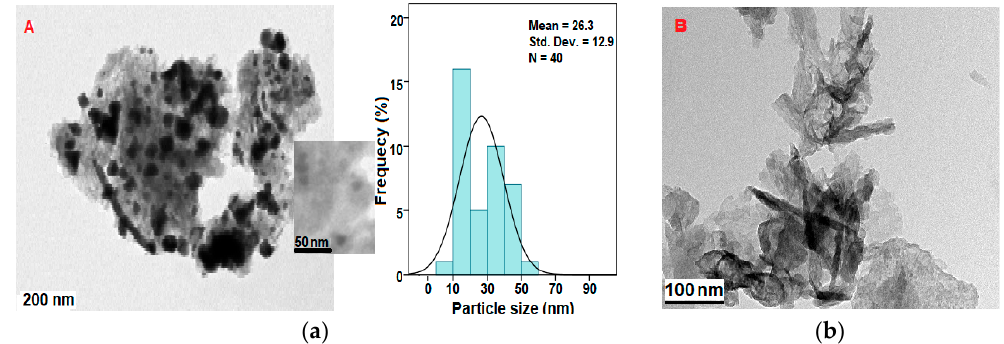
Figure 4. ( a ) Transmission electron microscopy (TEM) micrograph (A) and particle size distribution of gallic acid-intercalated in Zn/Al-LDH/Gd nanoparticles coated with AuNPs (GAGZAu) and micrograph (B); ( b ) of gallic acid intercalated in Zn/Al-LDH/Gd nanoparticles (GAGZA).